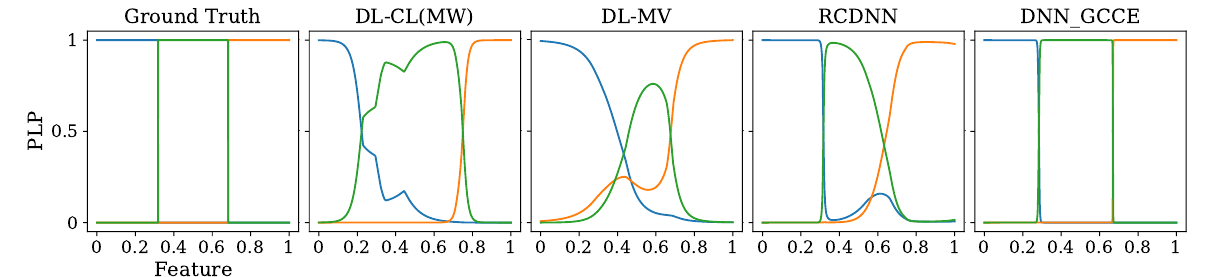
Figure 4. Synthetic results—1D dataset. The predictive label’s probability (PLP) is shown, comparing the prediction of our GCECDL (AUC = 0.99) against: DL-CL(MW) (AUC = 0.79), DL-MV (AUC = 0.9), and RCDNN (AUC = 0.99). Label classes are represented as blue, green, and orange.